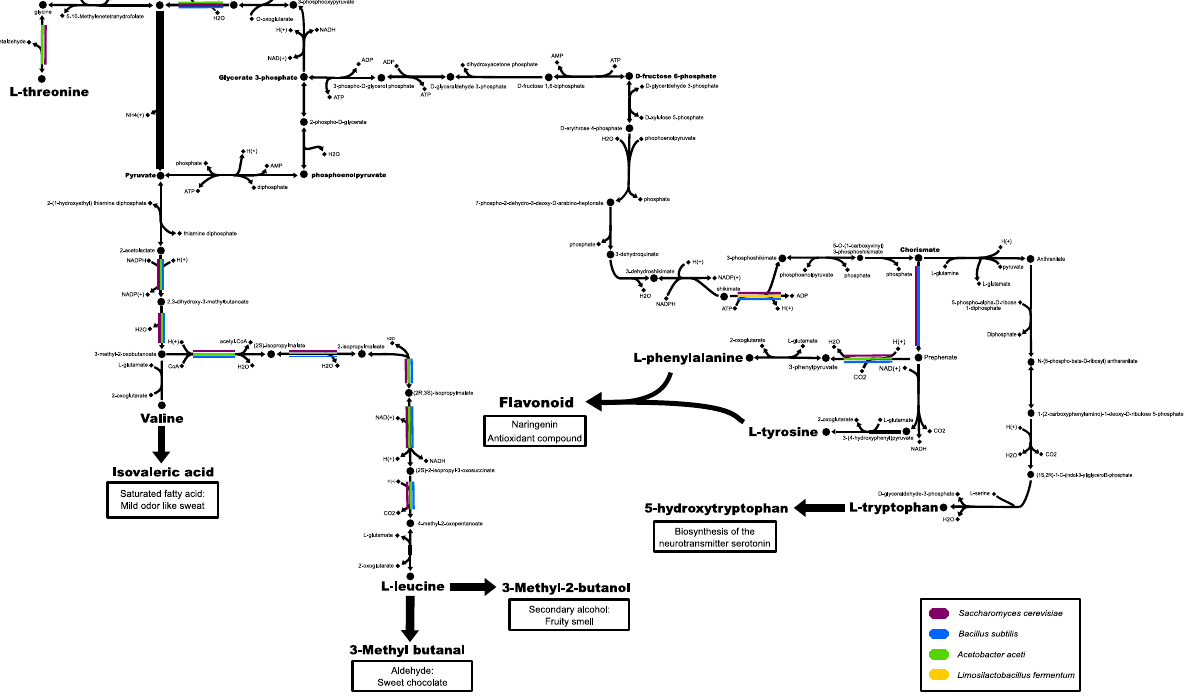
Figure 7. Network diagram of the amino acid synthesis pathway reconstructed at the community level. Production pathways for l-leucine, l-phenylalanine, l-tyrosine. l-tryptophan, valine and l-threonine are shown (bold-highlighted). These aminoacids have been recognized as crucial precursors of flavour/odour (e.g. 3-Methyl-2-butanol) and bioactive compounds (e.g. naringenin) in fine flavour cocoa. Black arrows represent metabolic reactions occurring in all the species of the community model (i.e. S. cerevisiae , B. subilis , L. fermentum and A. aceti ). Colours were used to indicate reactions that took place only on the indicated